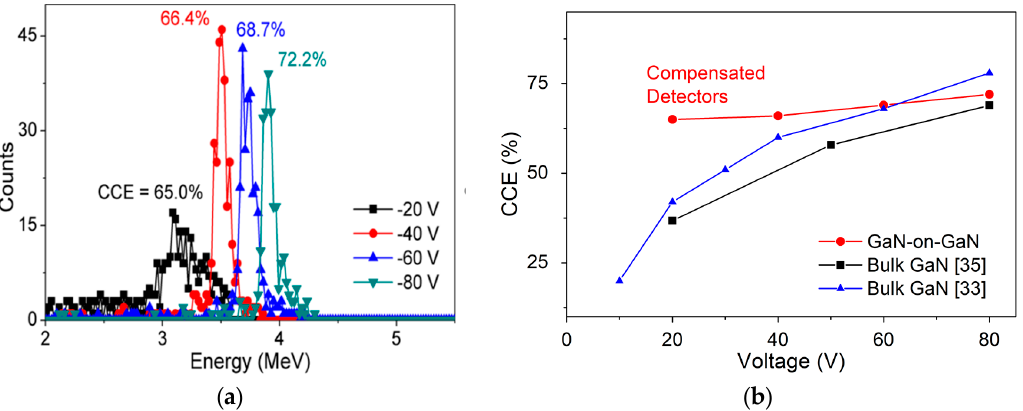
Figure 17. ( a ) Acquired α -particle spectra of compensated detectors for different voltages (–20 V to –80 V) and ( b ) Comparison of variation in CCE with voltages (–20 V to –80V) for state-of-the-art α - particle detectors.